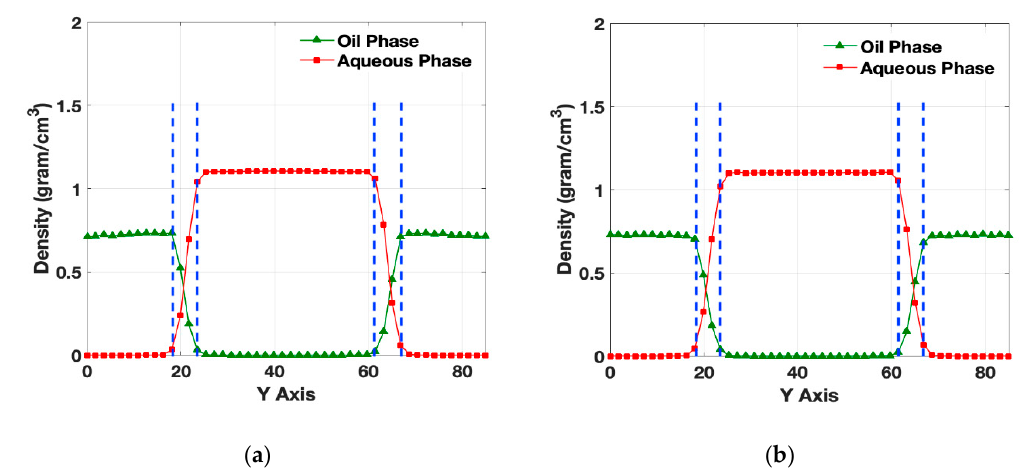
Figure 10. Density profiles of n-hexane and water system. Blue vertical lines indicate the location of the interfaces. In case ( a ), heat is being transferred perpendicular to the interfaces, while, in case ( b ), heat is transferred parallel to the interfaces.